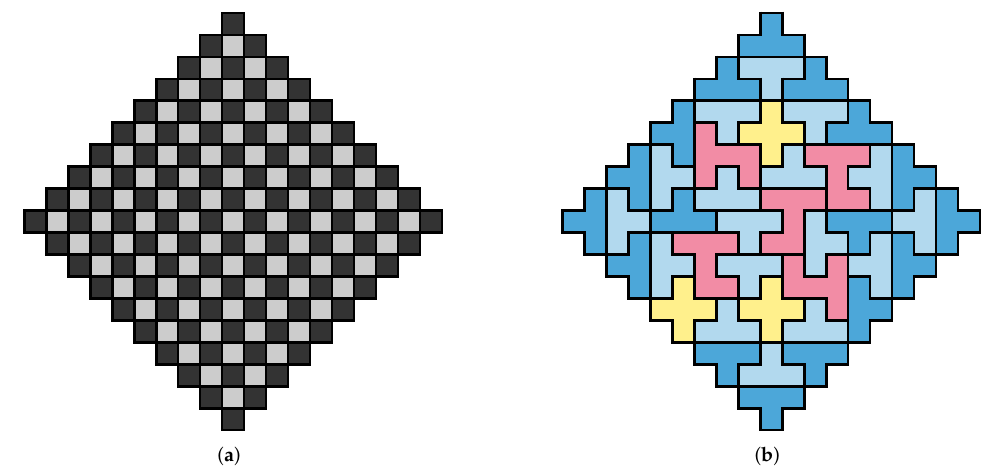
Figure 20. Target region and a tiling solution for Example 8: ( a ) the target region (cid:98) R , a checkerboard coloured diamond-shaped region; ( b ) successful tiling of the target region (cid:98) R using 34 copies of a T-shaped trimino, 5 copies of the Y-shaped hexomino, and 3 copies of the cross-shaped pentomino. The optimal solution corresponds to the first pariomino tiling subproblem in Table 4 using 17 copies of P + , 17 copies of P − , 5 copies of P + , and 3 copies of P + . The pariominoes P + , P − , P + , and P + are 2 3 2 3 1 1 1 1 coloured dark blue, light blue, red, and yellow,